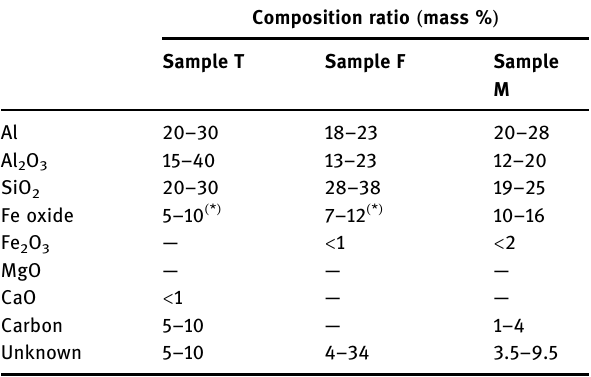
Table 1: Composition of exothermic sleeve materials